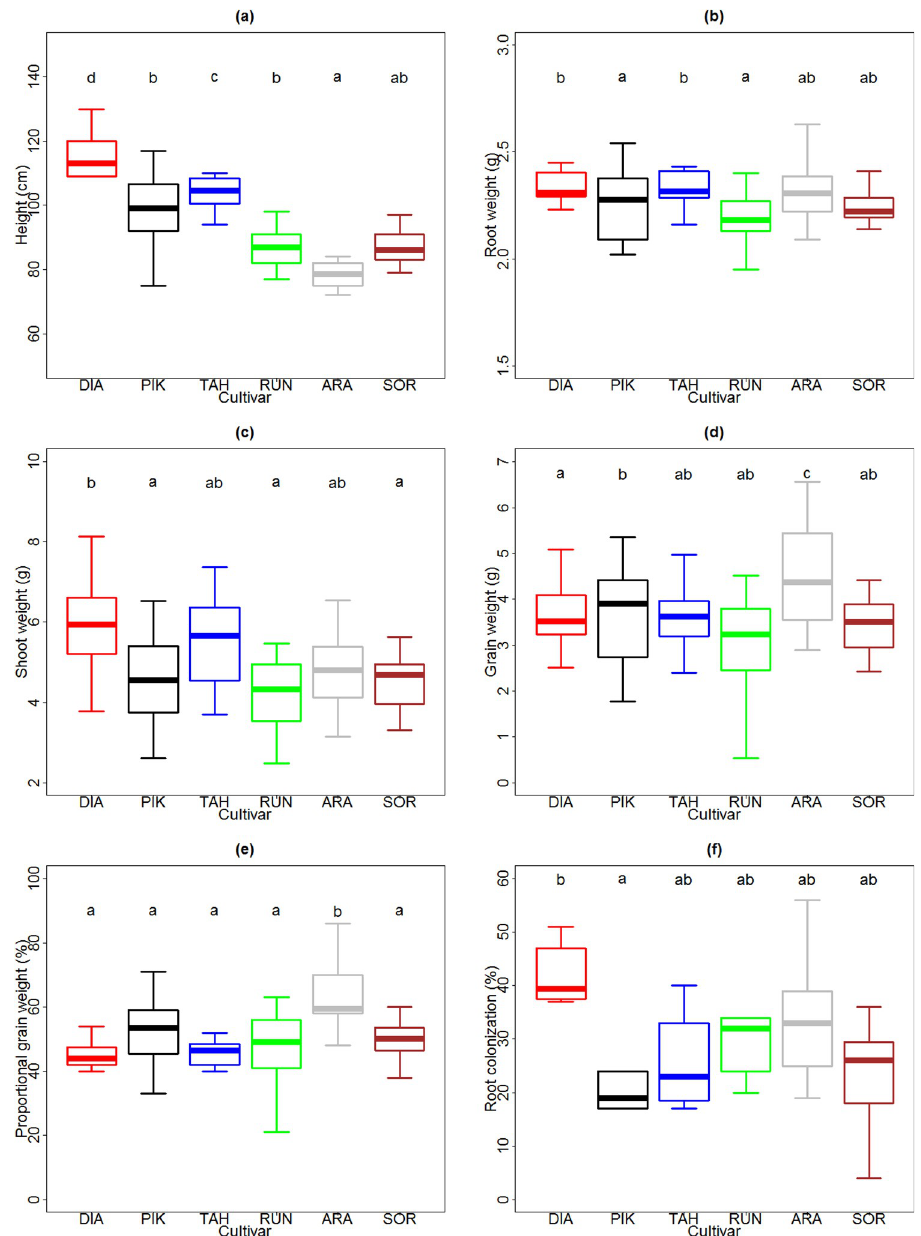
Fig 3. Differences between wheat cultivars in terms of plant traits: Height (a), root weight (b), shoot weight (c), grain weight (d), and proportional grain weight (e), and root colonization (f). f probably exaggerates the impression of differences, given that many bars represent 1–3 points. Thick lines represent medians; boxes indicate interquartile ranges; and whiskers show maximum and minimum values per sample. DIA: Diamant: 1929, PIK: Pikker 1959, TAH: Ta¨hti 1972, RUN: Runar 1972, ARA: Arabella 2012, SOR: Sorbas